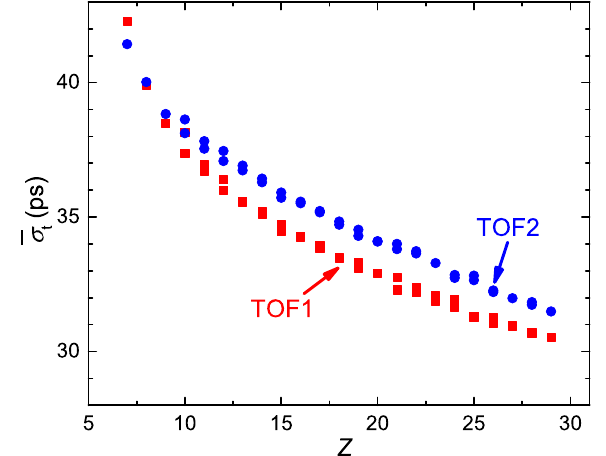
FIG. 9. Z dependence of the experimental time resolution of the TOF detectors deduced from the fit residuals using Eq.